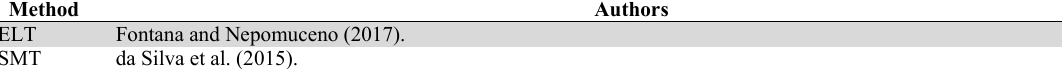
Relationship between multi-criteria methods and authors Method Authors